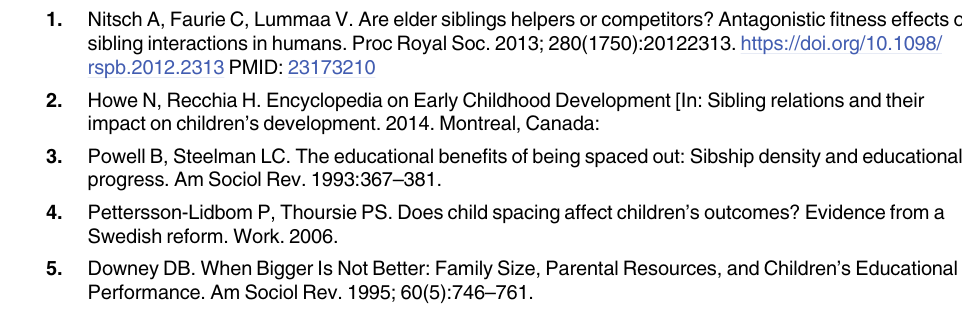
S3 Table. Relative risk (RR) a from interaction models for the association between develop- mental vulnerability on the Australian Early Developmental Census (AEDC) domains and Post-birth Interpregnancy Intervals